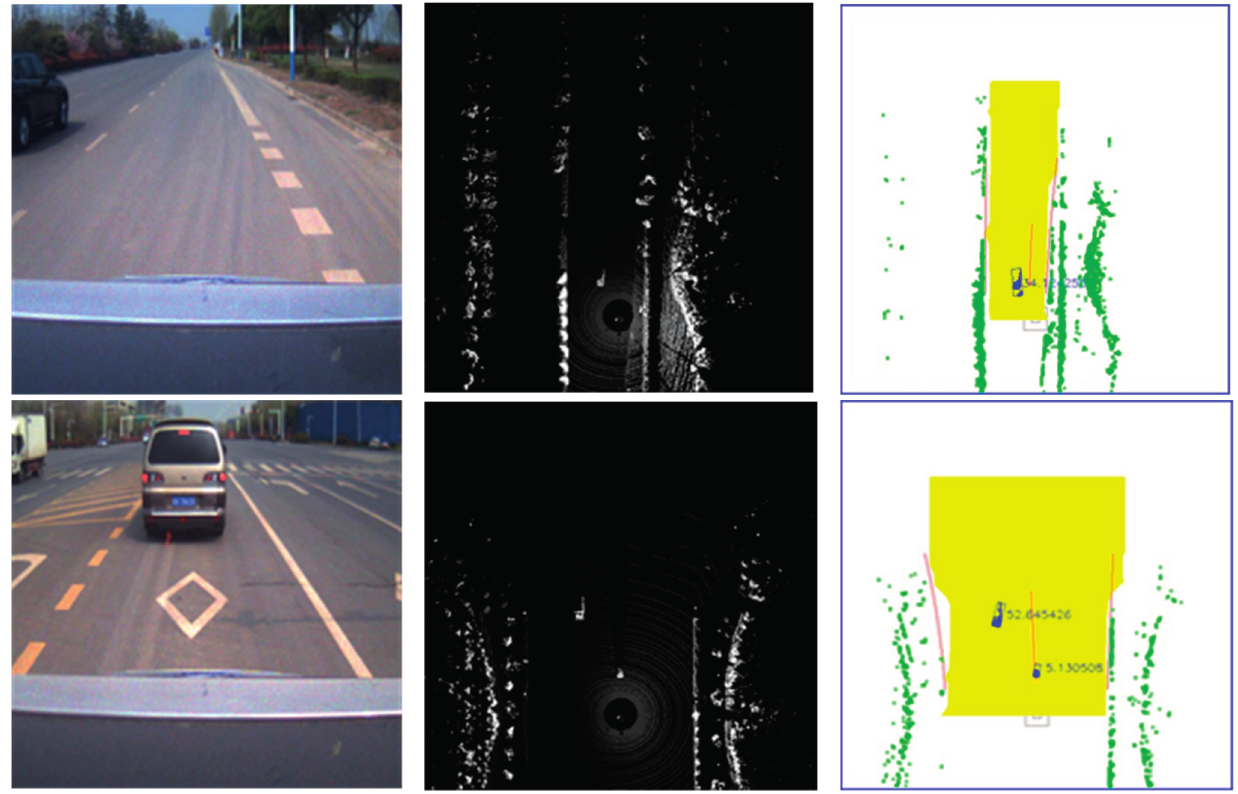
Figure 11. Dynamic obstacle track result. ( Left column ) Original image taken by a camera; ( Middle column ) Original grid map obtained by the Velodyne LIDAR; ( Right column ) Ground segmentation and dynamic obstacle track